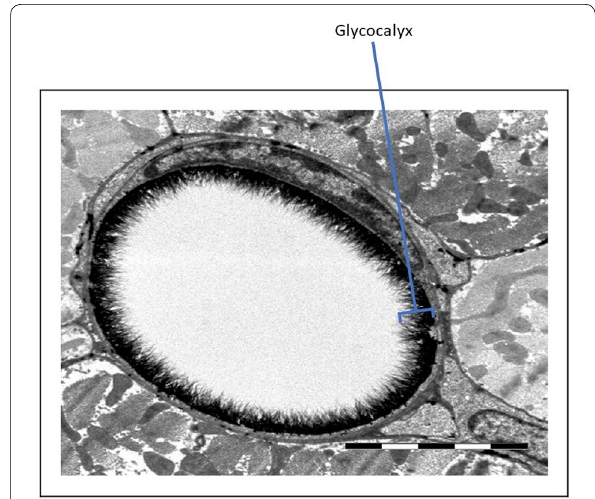
Fig. 2 Electron micrograph of a cross-sectional image of a coronary endothelial glycocalyx (courtesy of B. van den Berg, Maastricht University). Reproduced with permission from